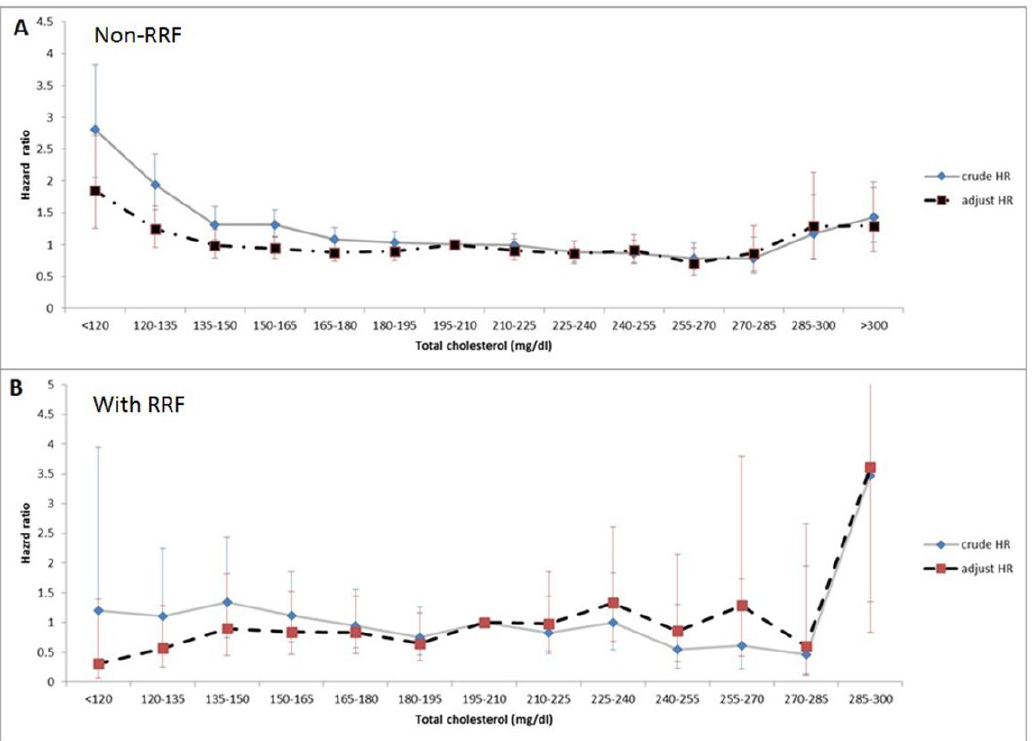
Figure 3. The unadjusted and adjusted hazard ratio (HR) of mortality in short interval TC levels demonstrated an U-shape curve among the patients without RRF ( A ) and linear curve among the patients with RRF (B).